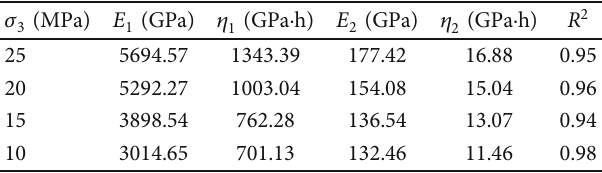
Table 4: Parameters of improved nonlinear viscoelastoplastic rheological model based on burgers model under 60% axial ultimate load.